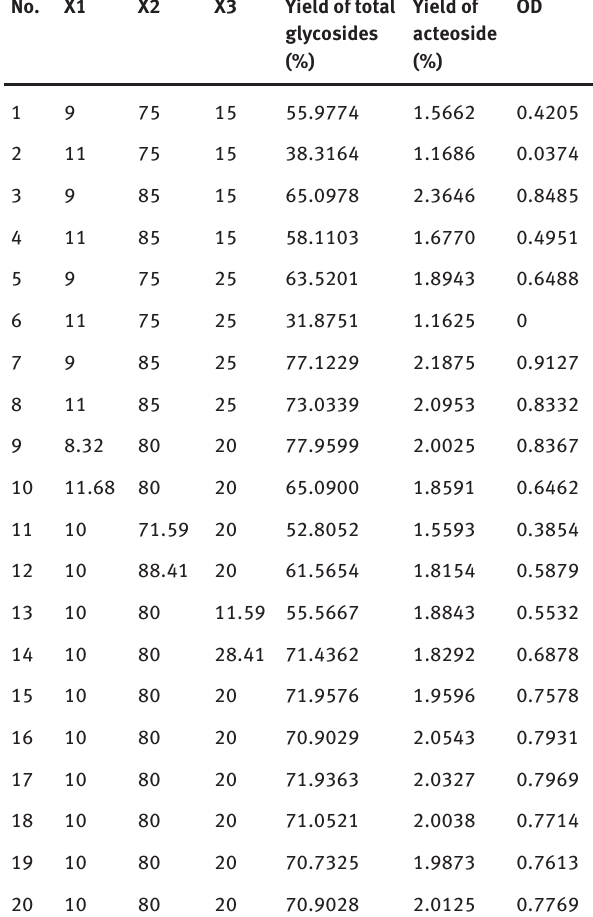
Table 2: Experimental results of central composite